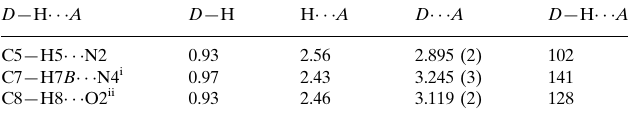
Hydrogen-bond geometry (A˚ , (cid:3)